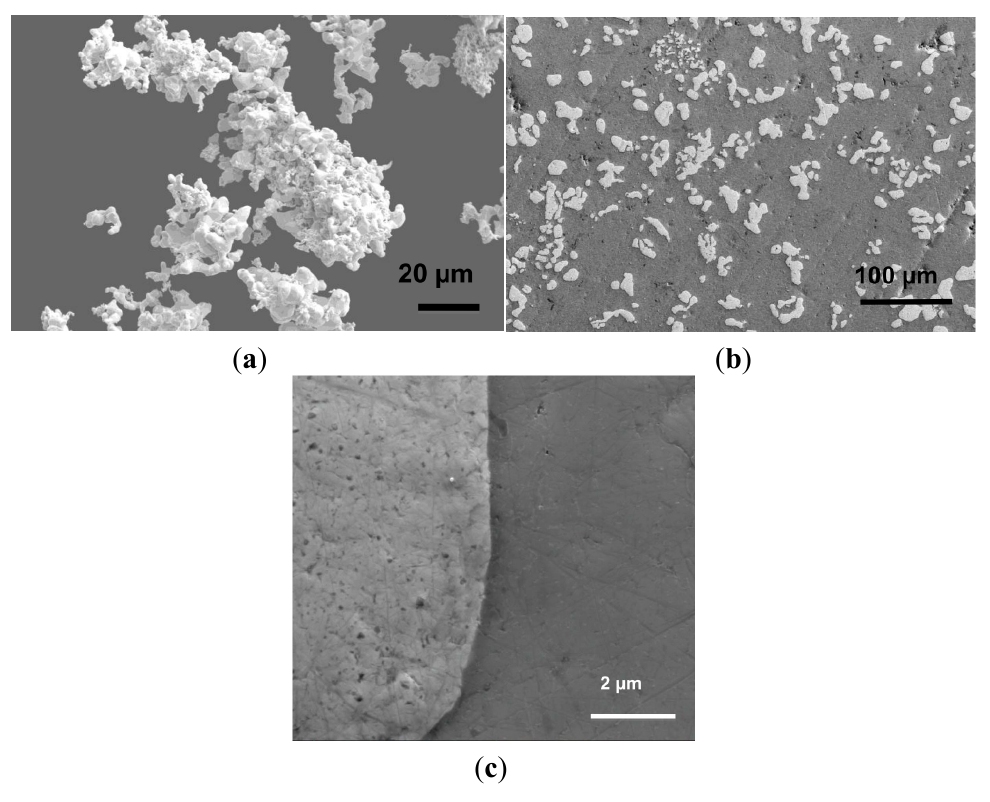
Figure 2. ( a ) XRD data showing Ta peaks superimposed on the amorphous pattern. ( b ) Differential scanning calorimetry (DSC) traces from La composite containing 20 vol. % Ta